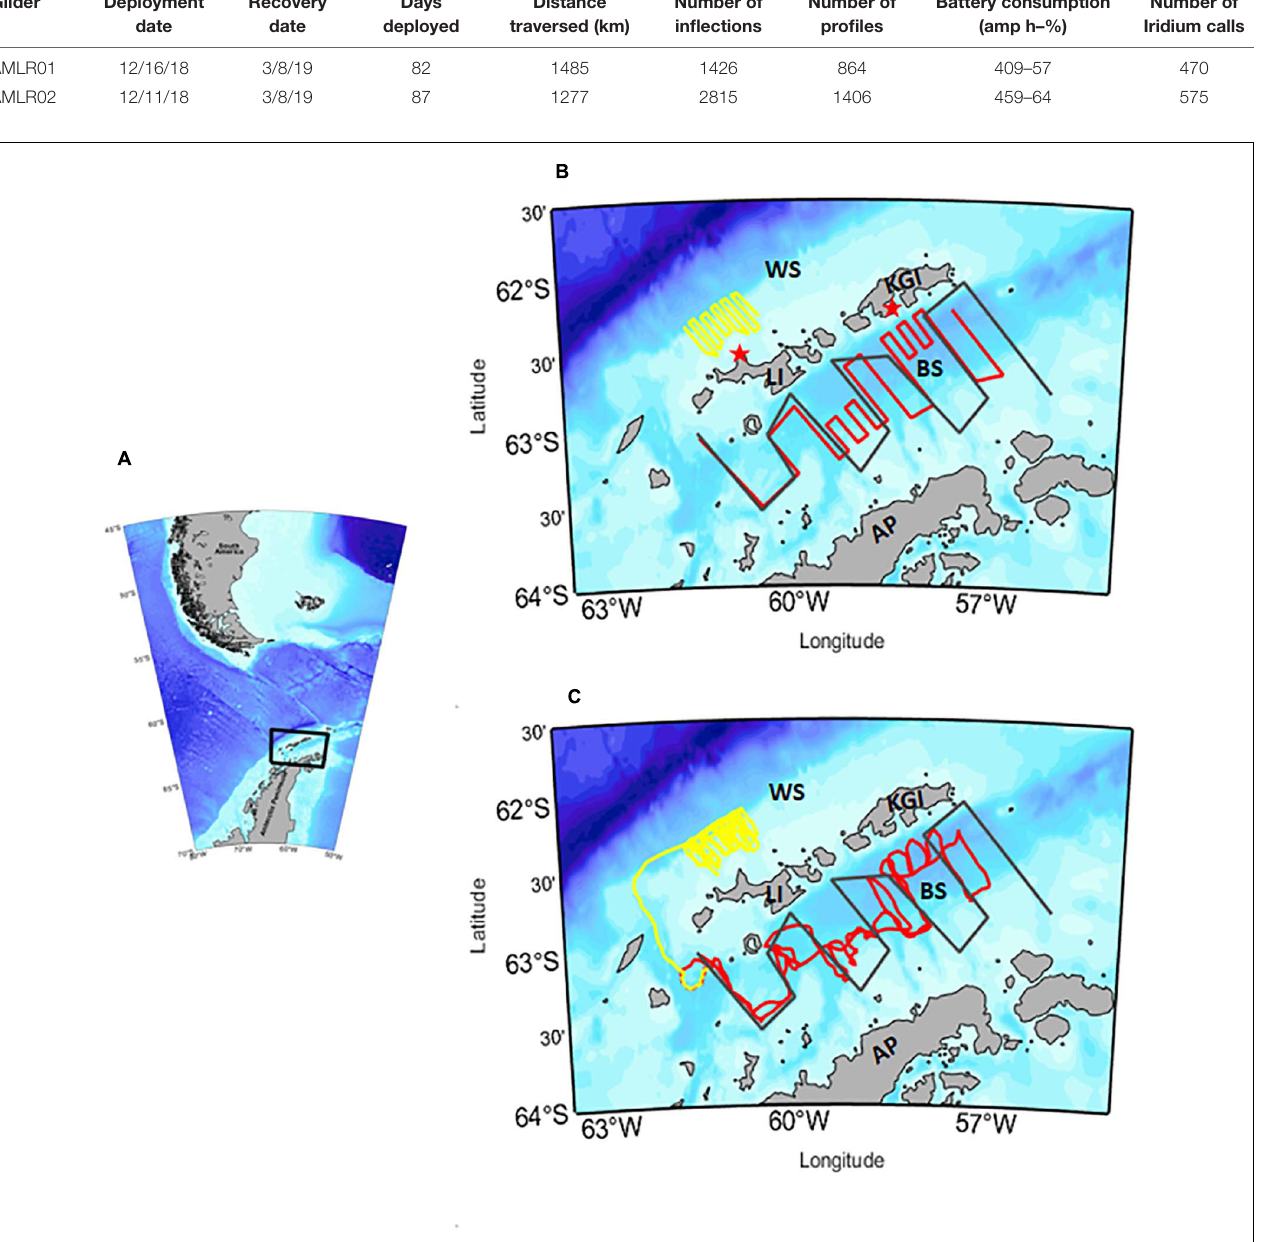
TABLE 1 | Deployment and recovery details for gliders flown around the South Shetland Islands and northern Antarctic Peninsula during the austral summer of 2018/19. Glider